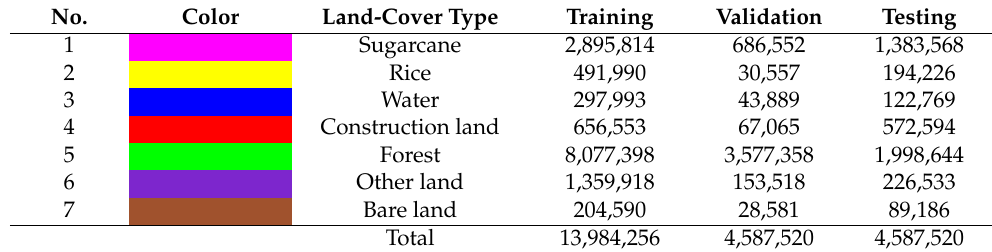
Table 2. Numbers of samples in the dataset II.